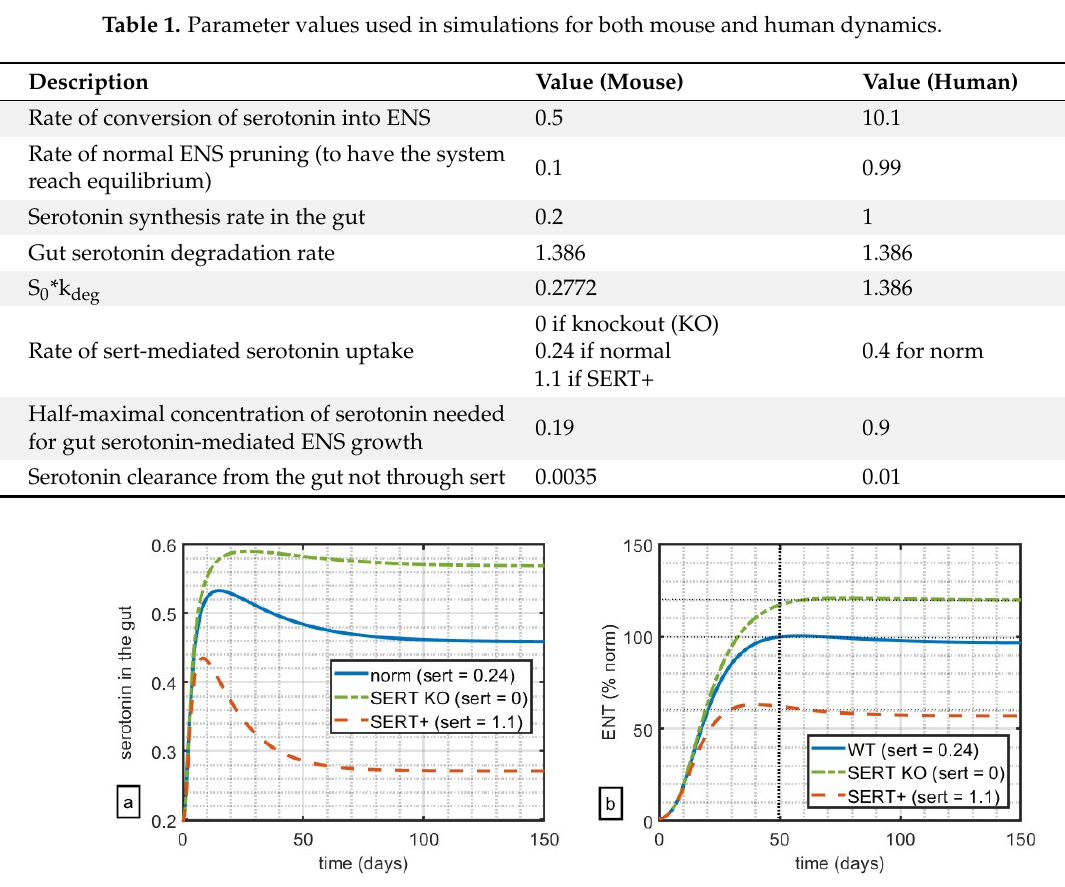
Figure 1. Impact of relative levels of SERT expression on ( a ) simulated serotonin in the gut and ( b ) size of the ENS relative to WT. At t = 50 days, WT mice had 100% ENS, with SERT KO mice at 120% of ENS, and SERT+ mice at 60% ENS relative to WT.